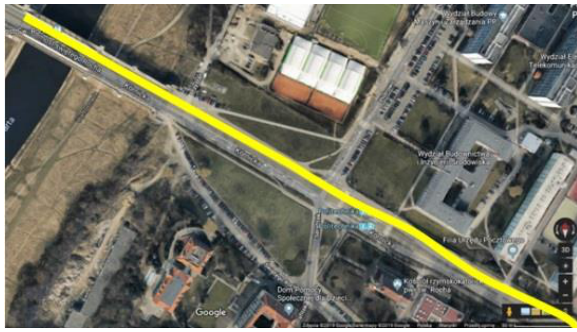
Fig. 1. Section of Kornicka Street in Poznan, used in this work for vehicles acceleration modeling [6]